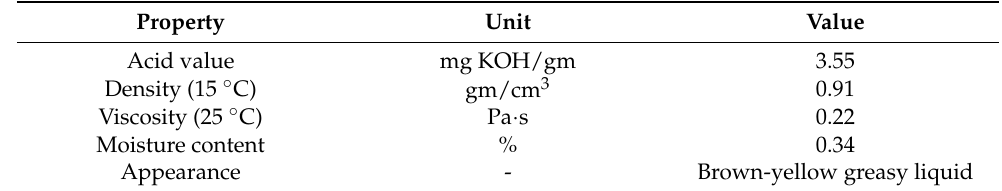
Table 3. Physical properties of